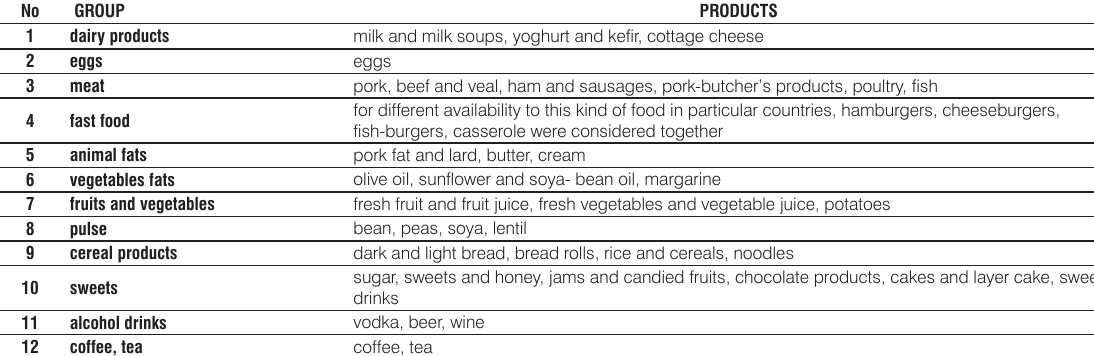
Table 1. The groups of food products